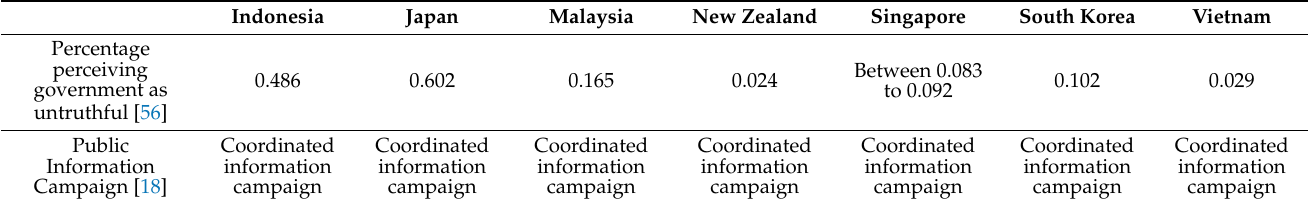
Table 6. Citizen’s trust towards the government handling the